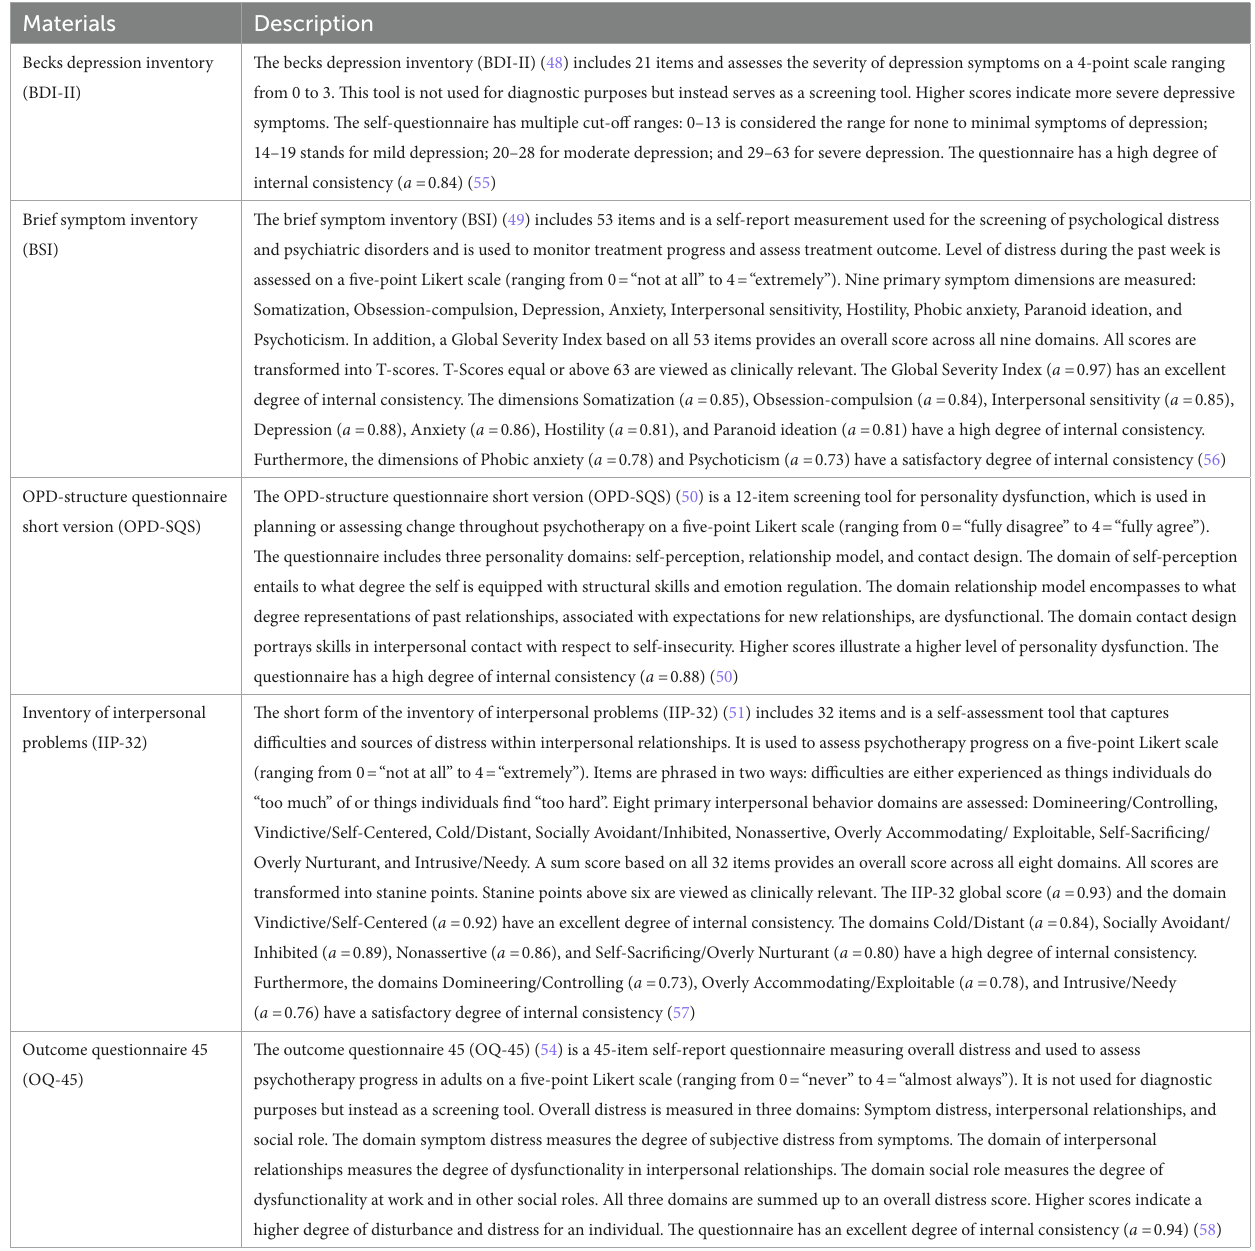
TABLE 1 Descriptions for the clinical assessments within the interview test